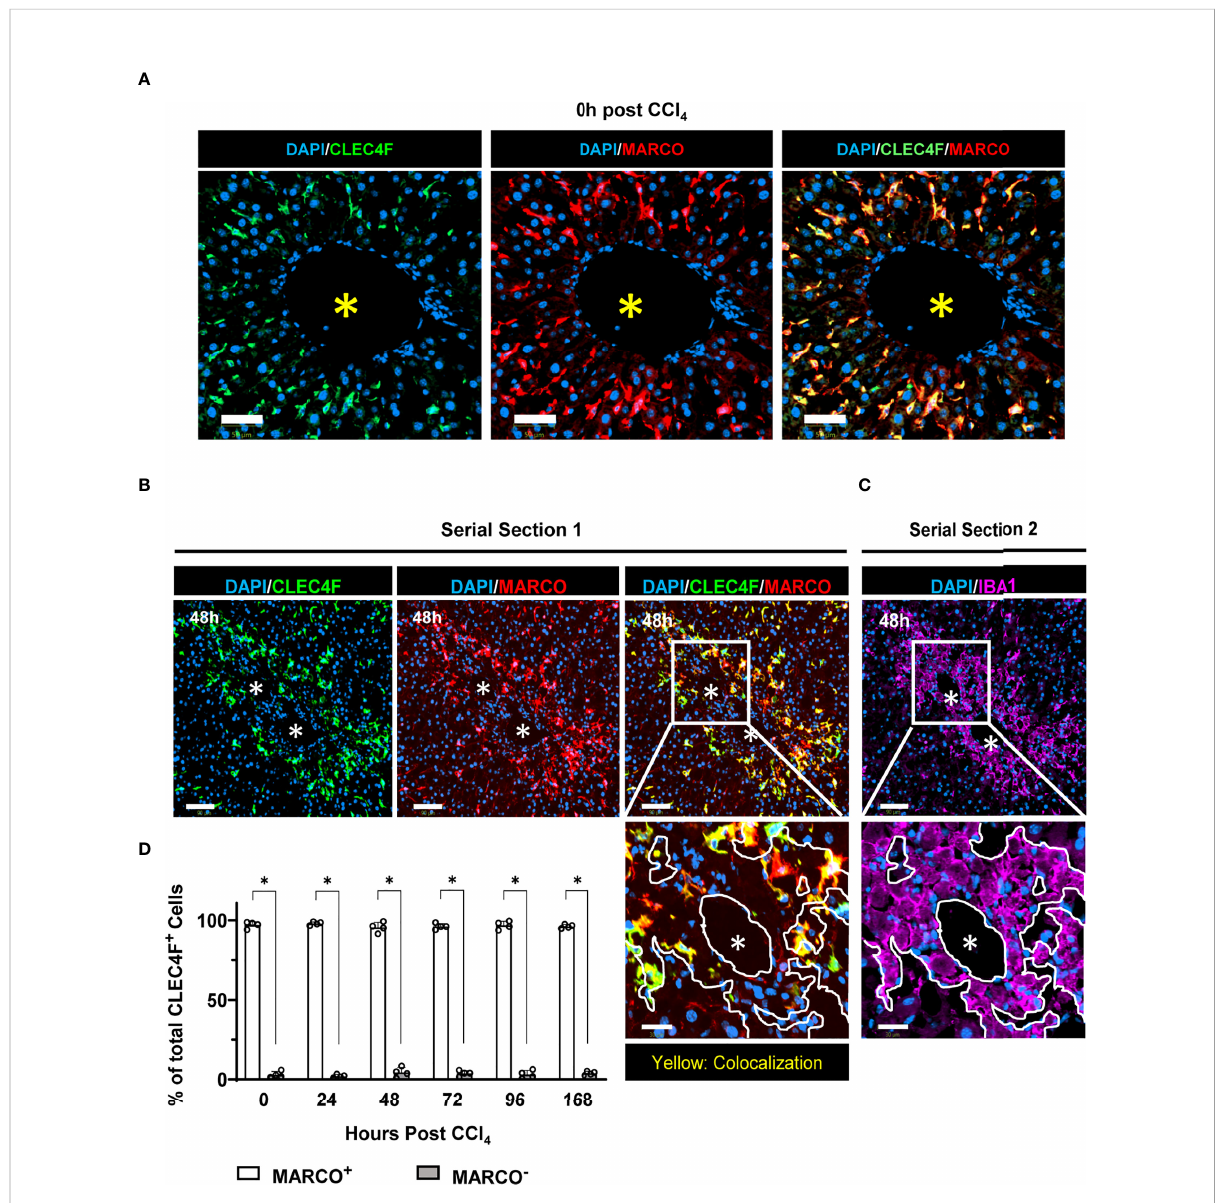
FIGURE 7 CLEC4F + KCs of yolk sac origin replenish the hepatic macrophage pool during tissue repair. (A) Representative mIF images from liver sections at the steady state (0 h), CLEC4F in green (left), MARCO in red (middle) and merge (right). Nuclei counterstained with DAPI (blue), scale bar 50 m m. (B) Representative mIF images from liver sections, CLEC4F in green (left), MARCO in red (middle), and merge (right) on serial section 1. (C) IBA1 IF (magenta) on serial section 2 (upper panel), scale bar = 90 m m. The inset shows high magni fi cation of the area delineated in the upper panel, scale bar = 30 m m, * indicates CVs. The demarcation (white lines) delineates the area occupied by IBA1 + cells around a CV. (D) Quanti fi cation of MARCO + vs. MARCO - CLEC4F + KCs. N=4 mice per group. Data are shown as mean ± SEM. Statistical analysis was performed using Mann – Whitney U test. * P <